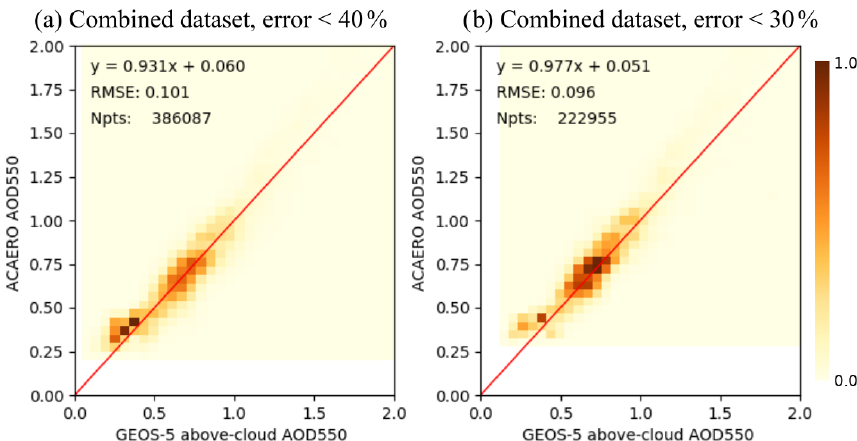
Figure 9. MOD06ACAERO retrieval results from the combined dataset of Fig. 3a compared to source GEOS-5 aerosol optical depth as a normalized density plot. AOD retrievals where COT was less than 4 and where the scattering angle was in the cloud bow are now discarded. Additionally the data extent had been limited to only include pixels with view zenith angle of less than 20 ◦ . Retrieval comparison shows further improvement. However, it is not clear if the reduction in dataset size is worth the gain in accuracy. Panel (a) shows MOD06ACAERO retrievals with uncertainty of less than 40%, and panel (b) shows the same with uncertainty less than